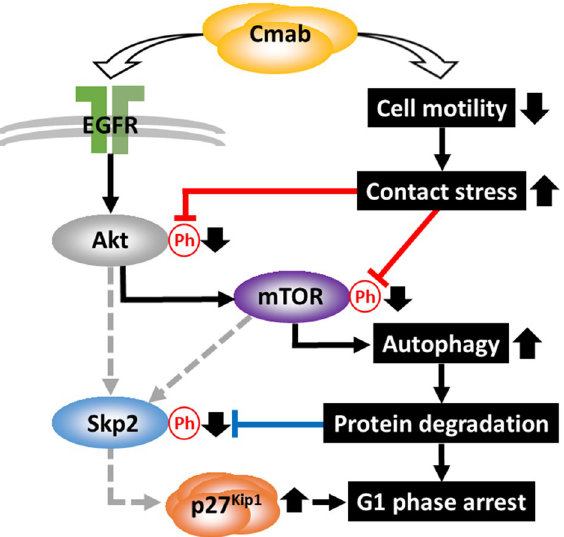
Figure 9. Mechanism of p27 Kip1 accumulation and autophagy induction following cetuximab treatment. Continuous inhibition of cell migration induced by prolonged cetuximab treatment resulted in decreased Akt and mTOR phosphorylation (red lines), which subsequently decreased Skp2 phosphorylation (blue line) and led to p27 Kip1 accumulation, due to the suppressed degradation of p27 Kip1 . The down-regulation of mTOR phosphorylation was also associated with autophagy